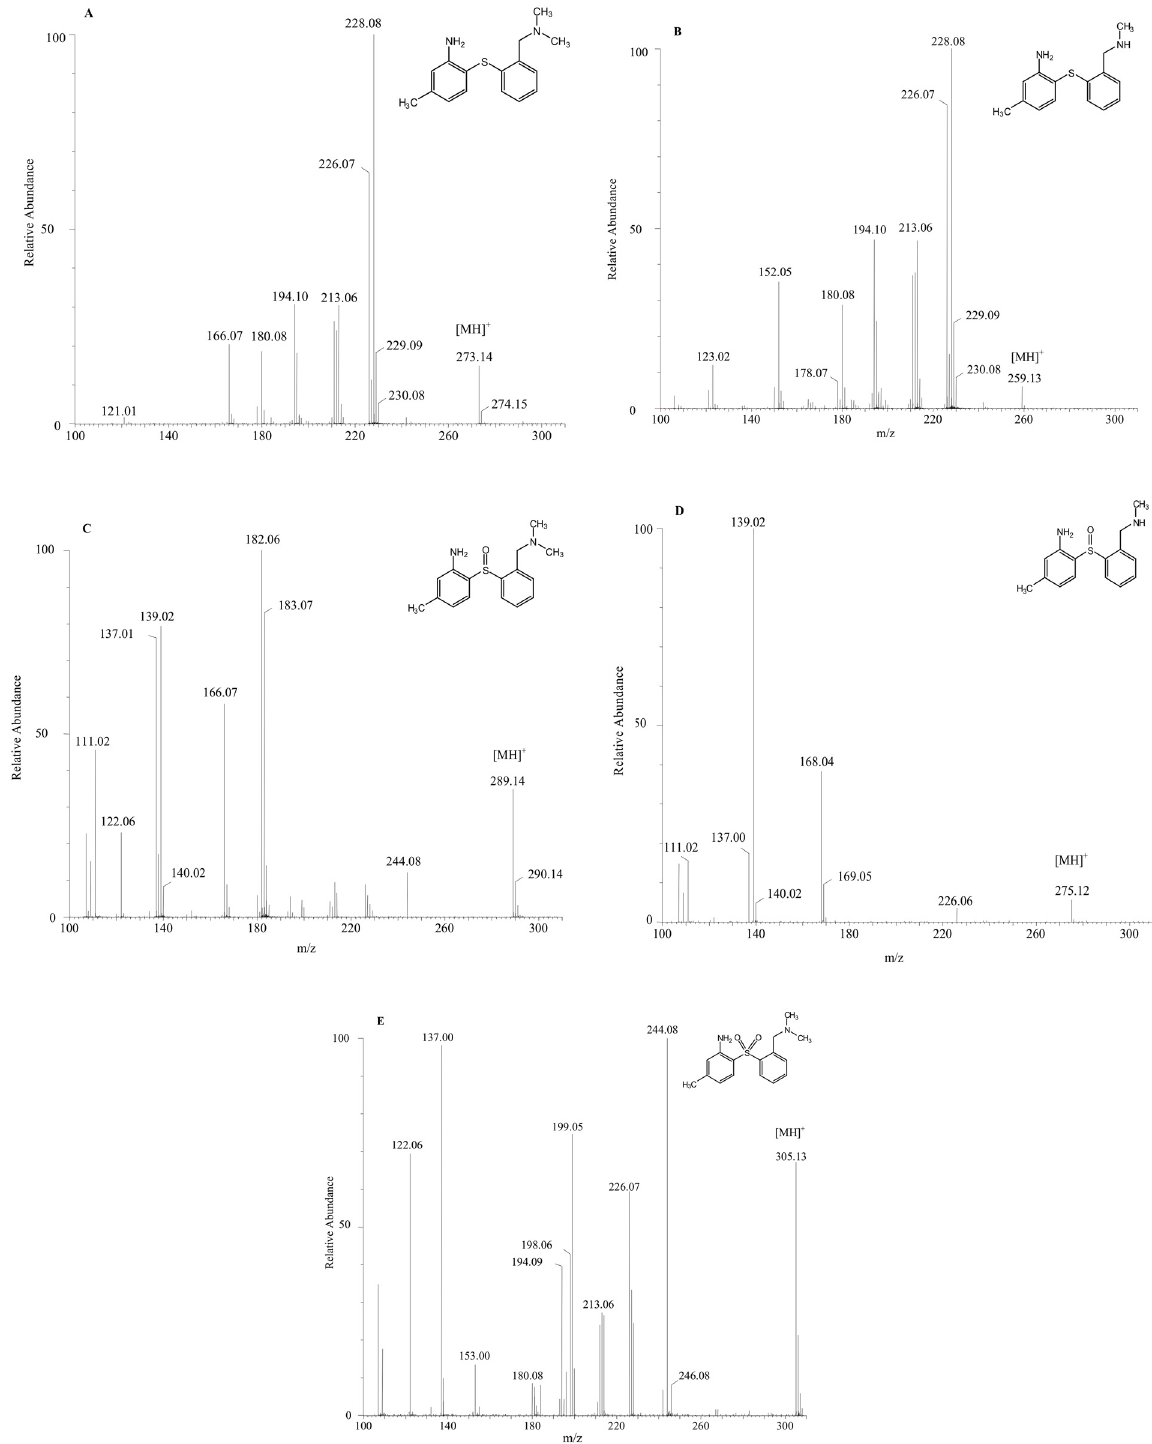
Fig 3. MS E spectra and structures of the synthesized reference compounds. (A) MADAM, (B) NHMADAM, (C) SOMADAM, (D) NHSOMADAM and (E) SO 2